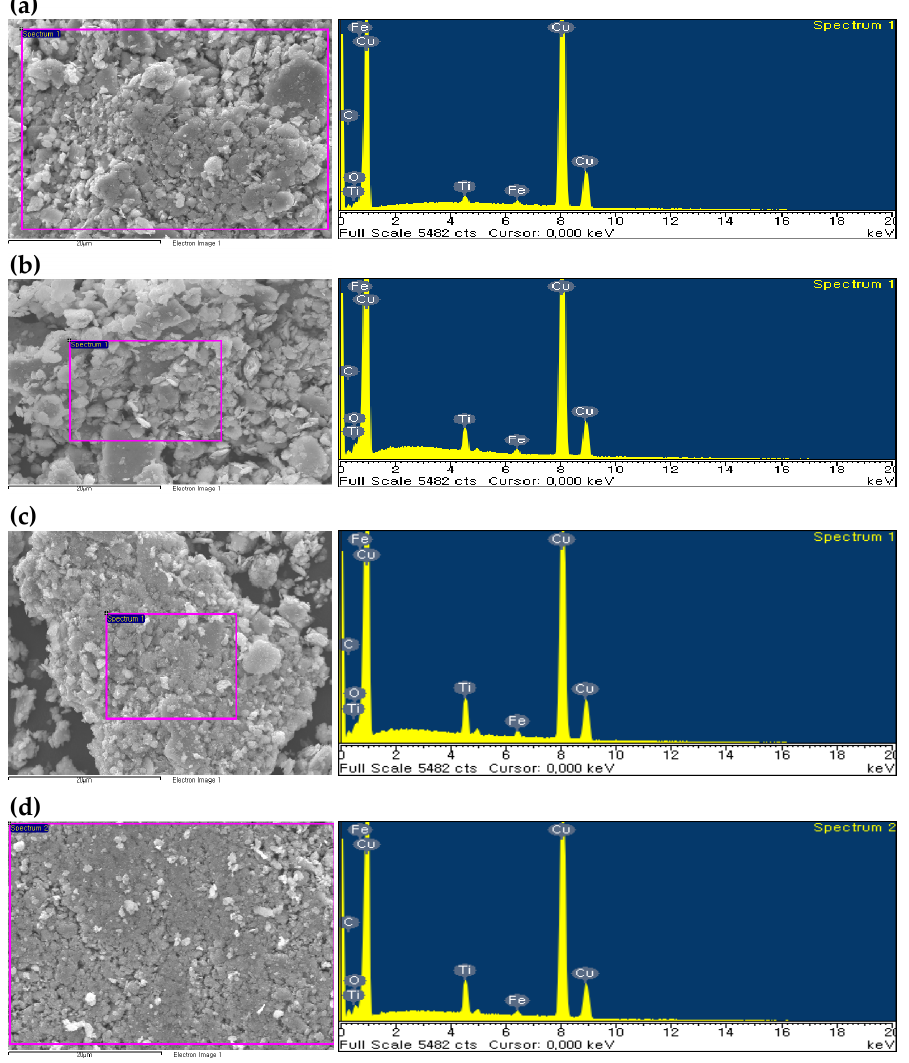
Figure 2. SEM images of as-milled composite powders ( a ) ex-situ Cu-TiC with 1 vol. % TiC; ( b ) ex-situ Cu-TiC with 3 vol. % TiC; ( c ) ex-situ Cu-TiC with 5 vol. % TiC and ( d ) in-situ Cu-TiH2-C with 5 vol. % TiC; The rectangles mark the areas from which energy-dispersive spectroscopy (EDS) spectra were taken.